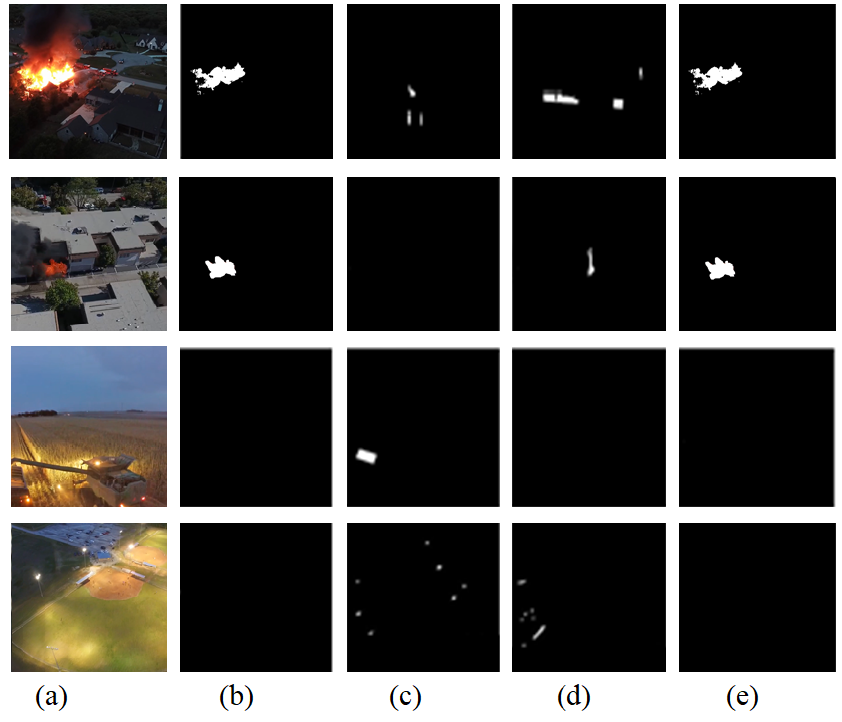
Figure 7. Qualitative comparison of the fire segmentation. From left: ( a ) images from the top two rows include fire and the bottom two rows are normal, ( b ) ground-truth, ( c ) single-stream encoder, ( d ) dual-stream encoder, ( e ) triple-stream encoder.